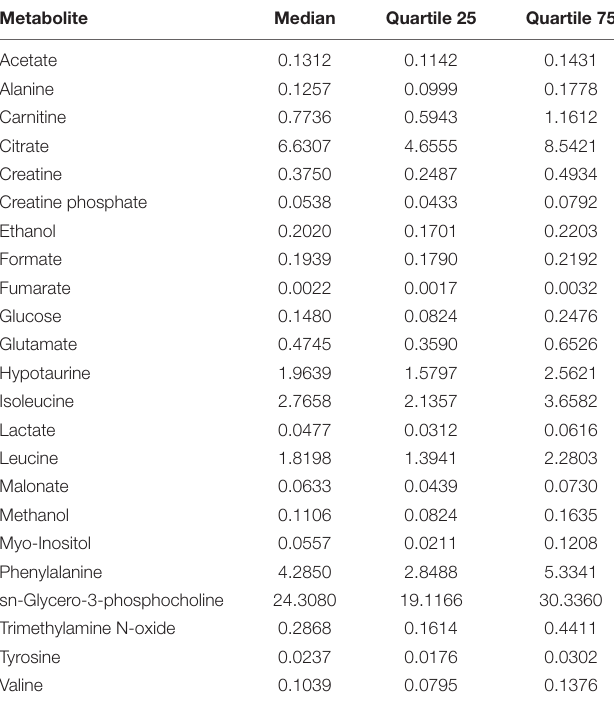
TABLE 1 | Concentration of metabolites (mM) in pig seminal plasma ( n =